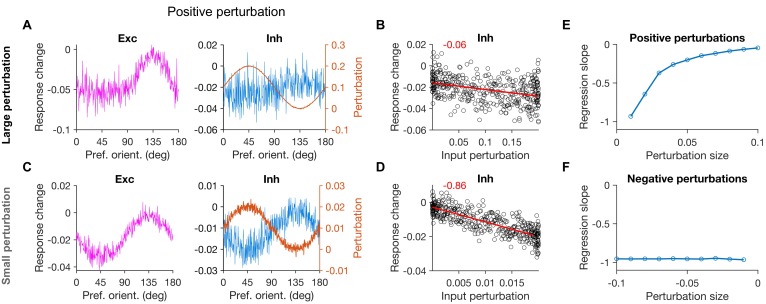
Specific paradoxical effect with positive perturbations.(A,B) Similar to Figure 2B,C, respectively, for positive patterned perturbations. The pattern of perturbation of inhibitory neurons is the same but reversed in sign. (C,D) Similar as (A,B) for a 10 times smaller perturbation size. The slope of the best fitted regression line is denoted on the top (red) in each case. (E,F) The slope of the best fitted lines to response changes versus input perturbations, for positive (E) and negative (F) perturbations of different size.